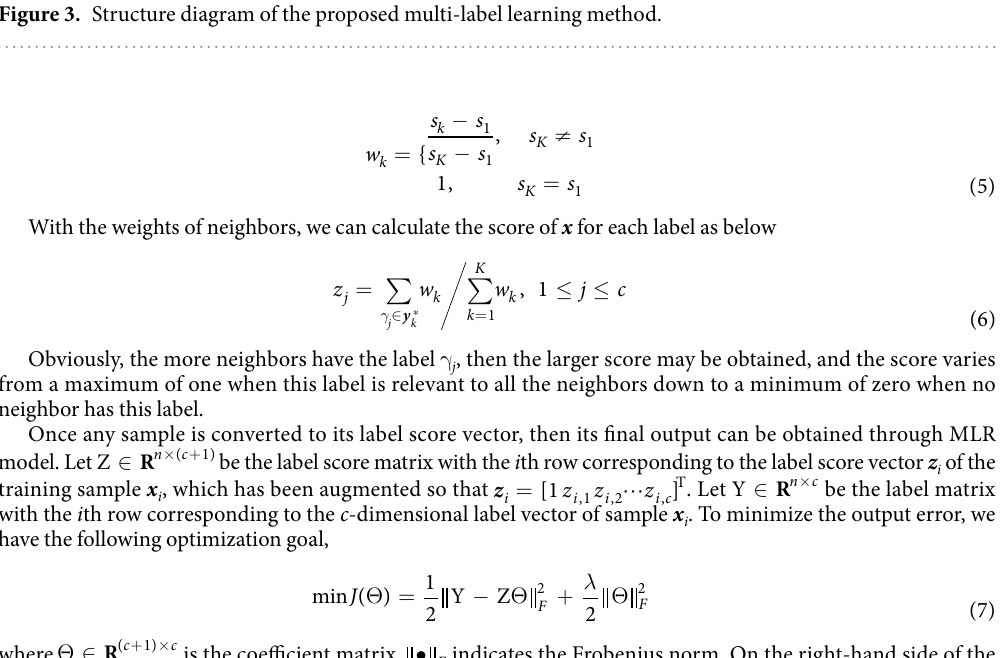
Figure 3. Structure diagram of the proposed multi-label learning